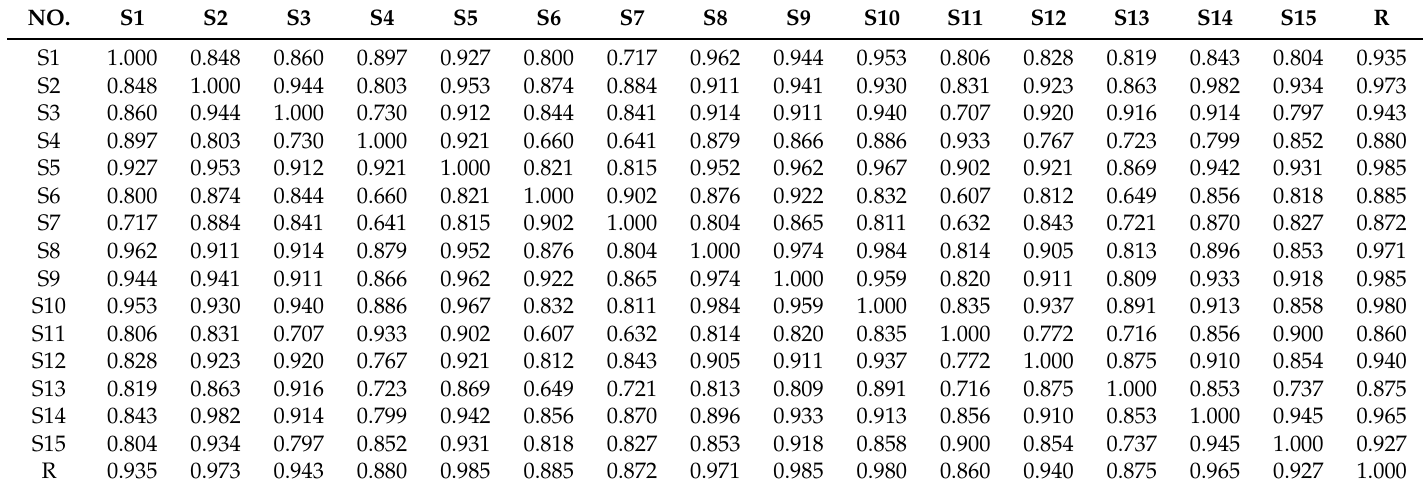
Table 1. The results of similarities of the chromatograms from different